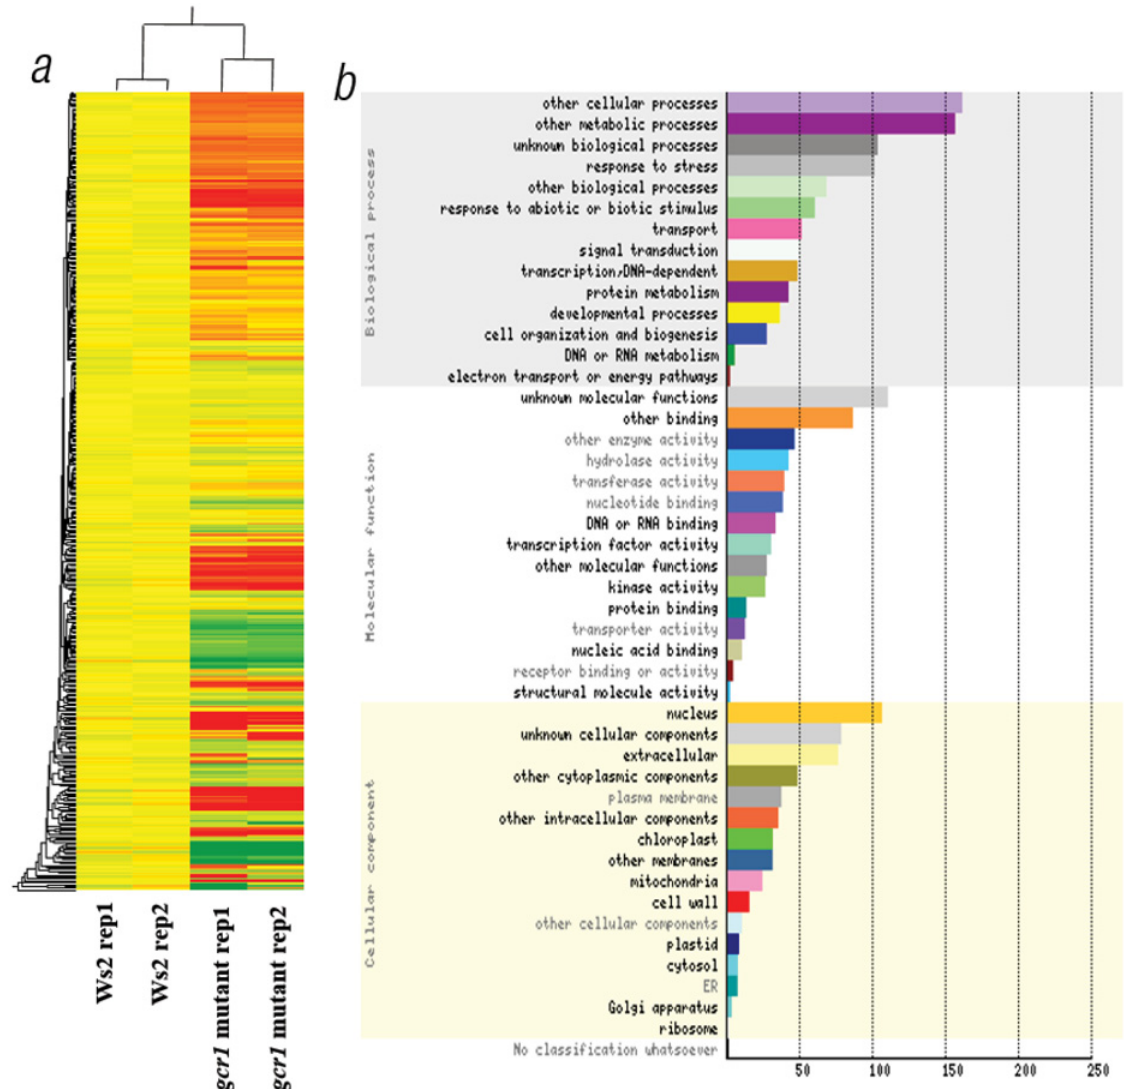
Fig 2. (a) Heat map of differentially expressed genes. The background-subtracted microarray data was subjected to hierarchical clustering using Genespring software ver. 11.5 to generate the heatmap. Yellow represents the control data, while red and green represent up-regulation and down regulation respectively. (b) GO categorization of DEGs. The DEGs were categorized into GO classes using classification superviewer tool of Bioarray resource (www.